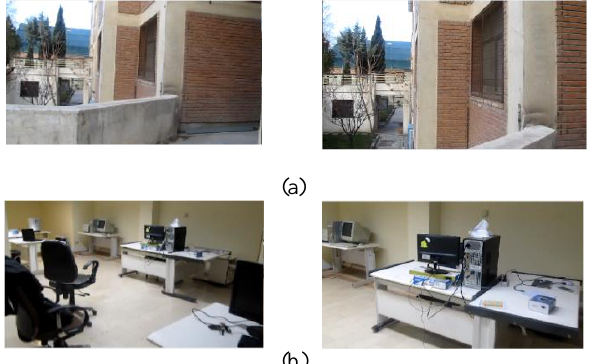
Figure 2. a. The first datasets, b. The second datasets